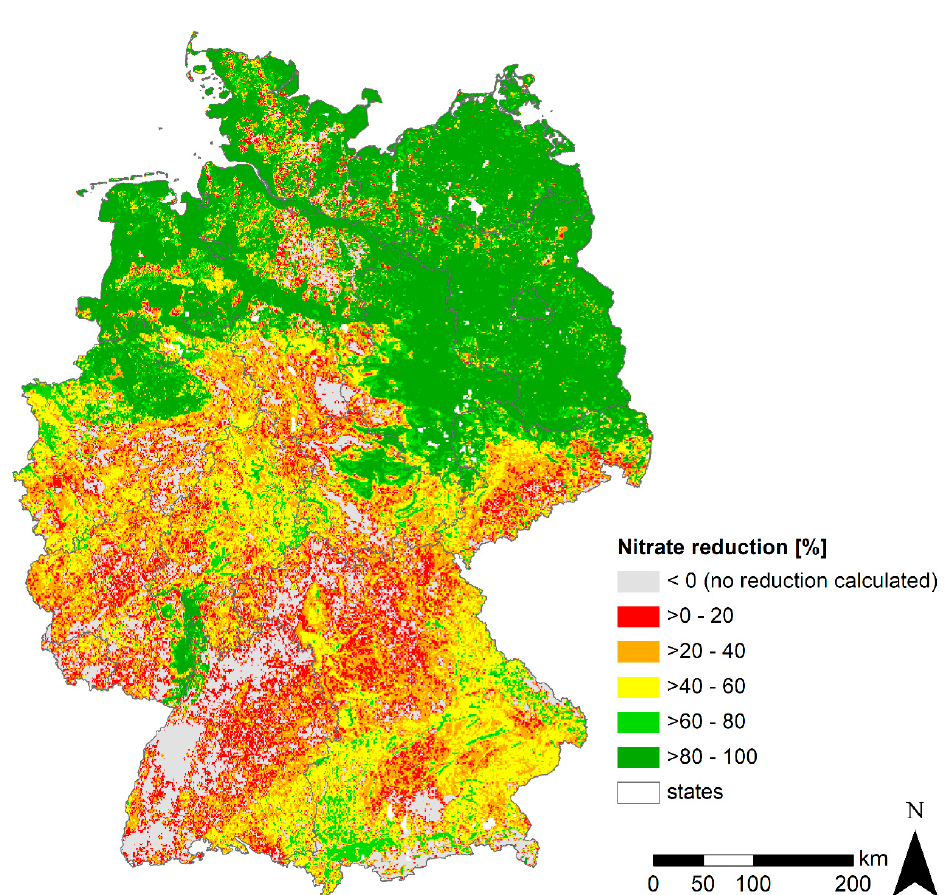
Figure 4. Map of mean nitrate reduction (NO 3 -N_red) across the unsaturated zone and the groundwater based on a 1 km × 1 km grid map of Germany (federal state borders: © GeoBasis-DE / BKG, 2017).